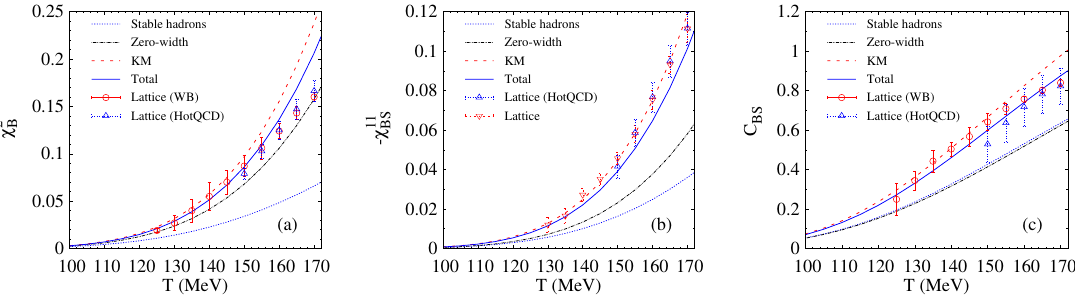
Figure 2. Temperature dependence of second order susceptibilities ( a ) χ 2 chemical